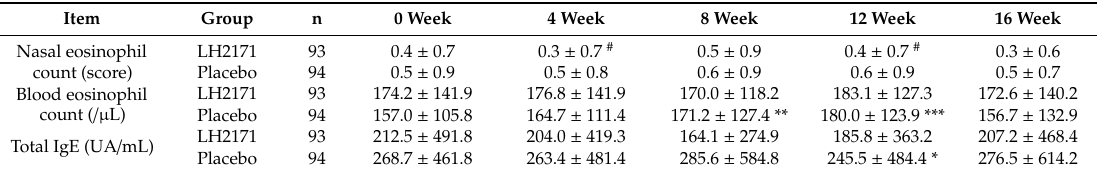
Figure 3. Changes in the eosinophil counts in the blood. Data are shown as the mean ± SD. Data were analyzed using the unpaired t-test. # p < 0.05 denotes statistically significant differences between groups. ● ; LH2171 group, ▲ ; placebo group. Table 5. Changes in blood eosinophils, total IgE levels, and eosinophils counts in nasal secretions.